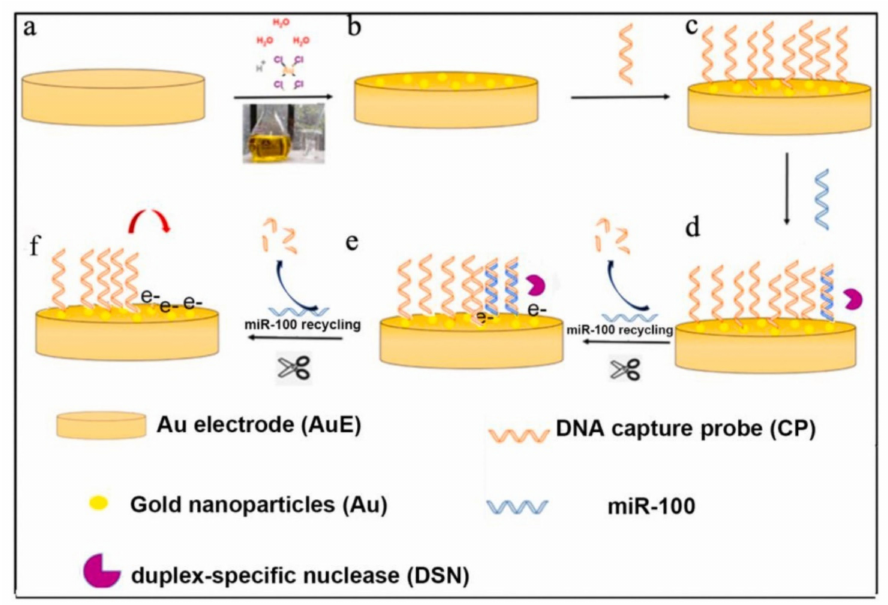
Figure 1. Schematic workflow for electrochemical detection of miR-100 using AuNPs-modified AuE coupled with DSN-assisted target recycling for signal amplification. Reprinted from [28] with permission from